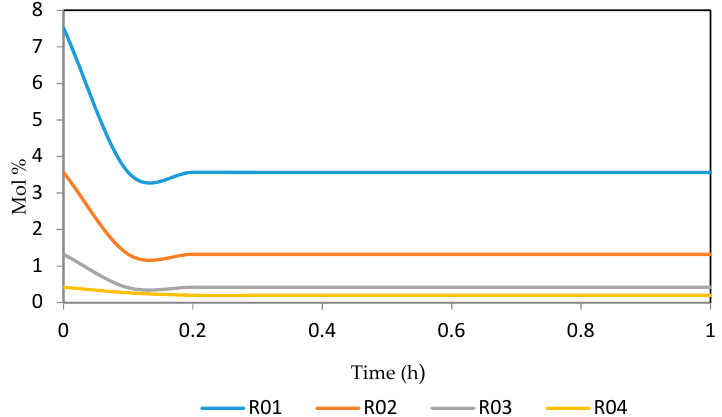
Figure 24. Dynamic behaviour of N 9 in the four reactors.